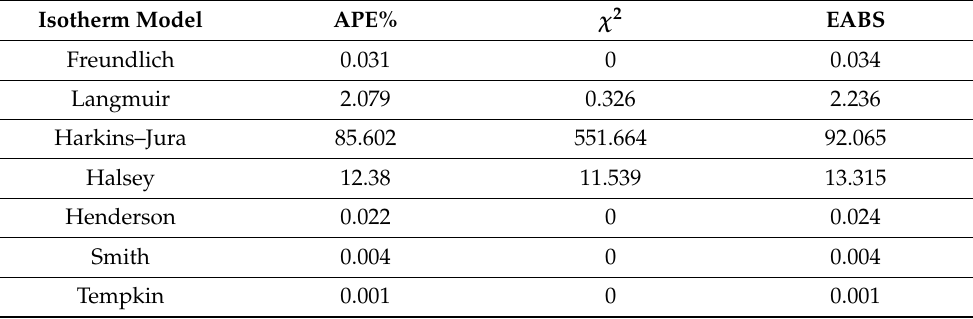
Table 3. The most appropriate isotherm model to investigate the equilibrium data through various errors functions.